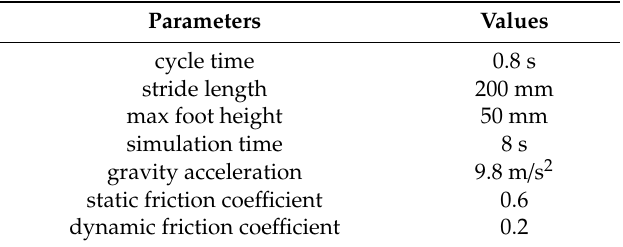
Table 1. Simulation parameters of hydraulic quadruped robot.